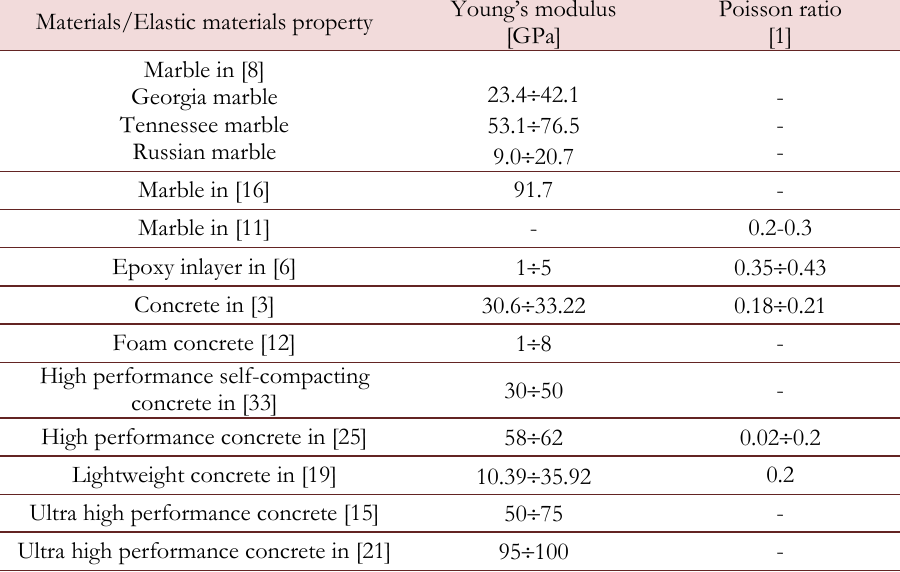
Table 1: Information of selected material